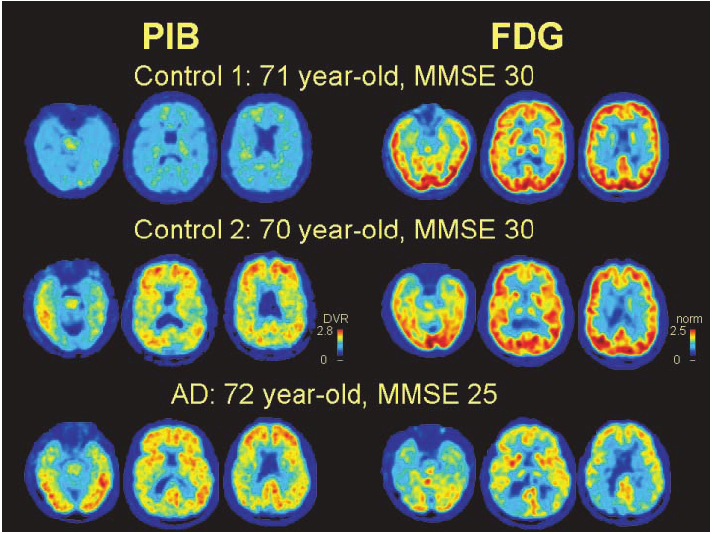
Fig. 1. PIB and FDG in controls and Alzheimer’s disease (AD). Control 1 demonstrates only non-specific PIB binding to white matter (top row, left), while Control 2 shows diffuse cortical and striatal PIB binding (middle row, left) that is indistinguishable from binding in a patient with AD (bottom row, left). However, only the AD patient demonstrates reduced glucose metabolism on FDG-PET (bottom row, right), whereas both controls show intact resting metabolism (top and middle row, right). PIB images are parametric distribution volume ratio (DVR) images using a cerebellar reference region, while FDG images are normalized to mean activity in pons. All images are in neurologic orientation. MMSE – Mini-Mental State